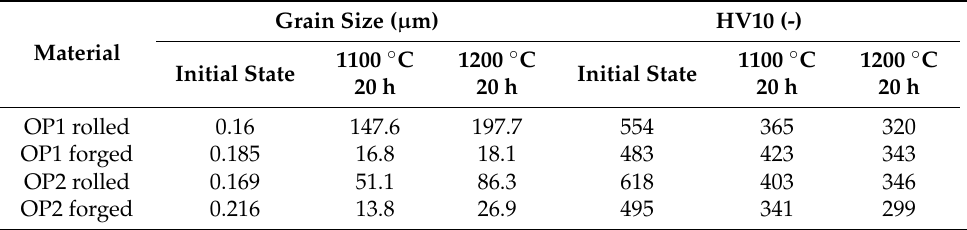
Figure 3. Microstructures from scanning electron microscope imaging of the consolidated alloys: ( a ) oxide precipitation (OP1)—after rolling, ( b ) OP1—after forging, ( c ) OP2—after rolling, ( d ) OP2—after forging (RD—rolling direction, FD— forging direction, arrows—precipitates). Table 2. Grain size and hardness of the experimental alloys after different heat treatments.